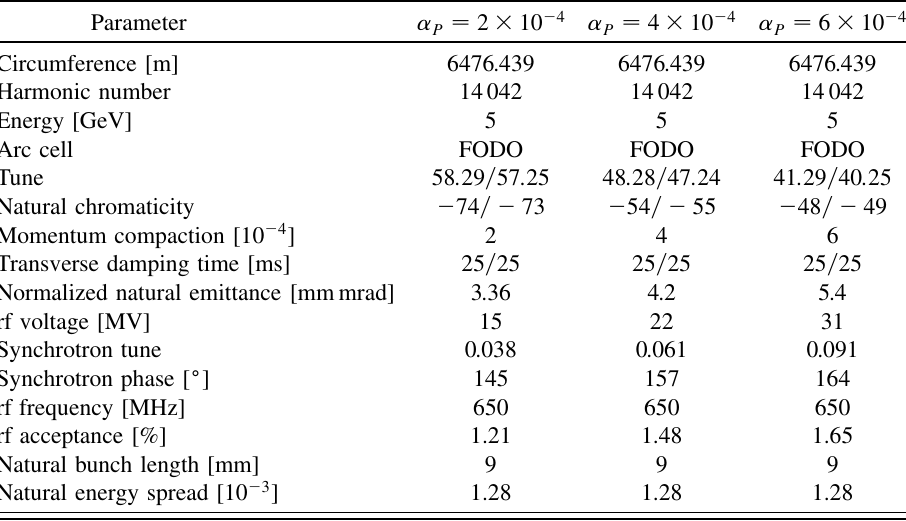
TABLE I. The main parameters of three critical damping ring running